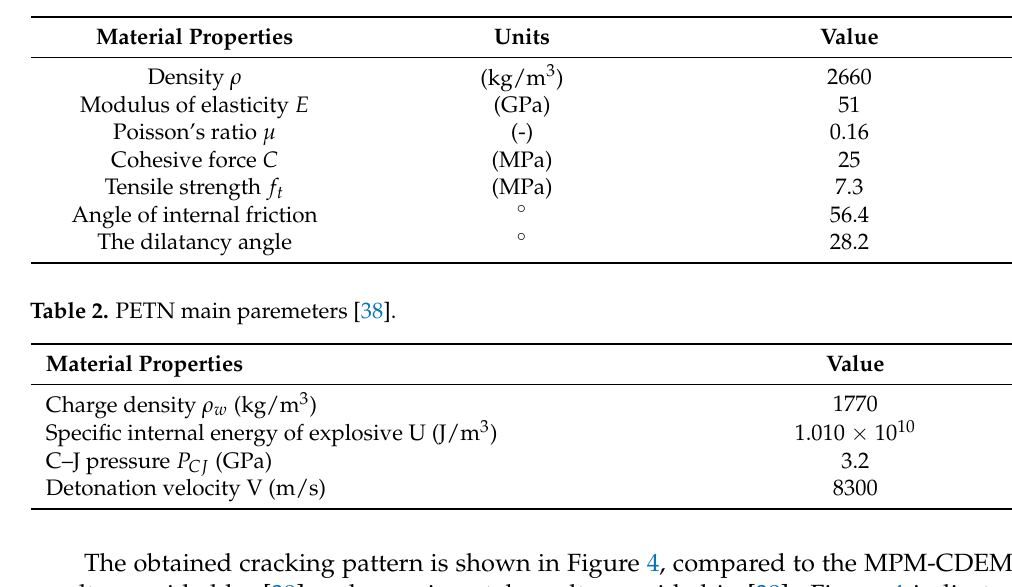
Table 1. Granite model main parameters [39].